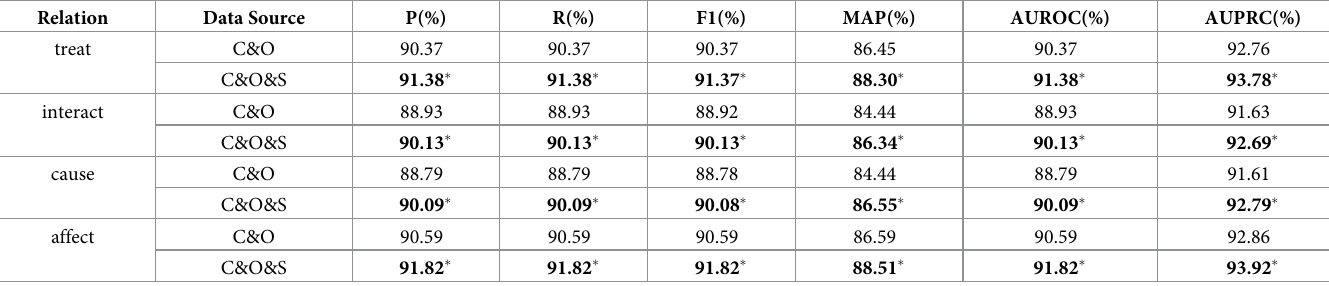
Table 9. The edge prediction results of COS and COS without using the semantic predications data source.